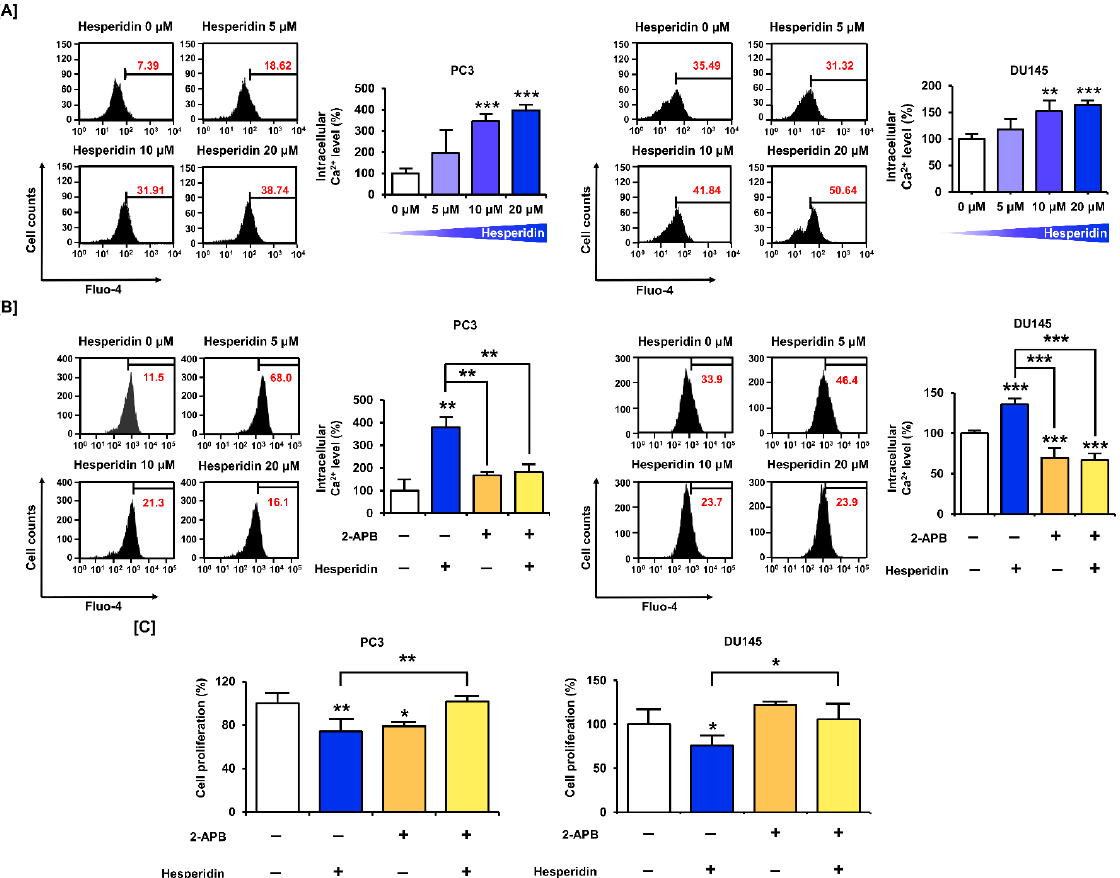
Figure 4. Effect of hesperidin on intracellular Ca 2+ levels in prostate cancer cells. ( A ) Changes in intracellular Ca 2+ concentrations after hesperidin treatment were determined via fluo-4 staining in PC3 and DU145 cells. ( B ) Changes in intracellular Ca 2+ concentrations via co-treatment with hesper- idin and 2-aminoethyl diphenyl borate (2- APB; 2 μM) were determined via fluo -4 staining in PC3 and DU145 cells. ( C ) Relative proliferation of PC3 and DU145 cells was verified after co-treatment with hesperidin and 2-APB for 48 h. All results of the arithmetic mean ( n = 3) denote statistical sig- nificance with asterisks (* p < 0.05, ** p < 0.01, and *** p < 0.001).